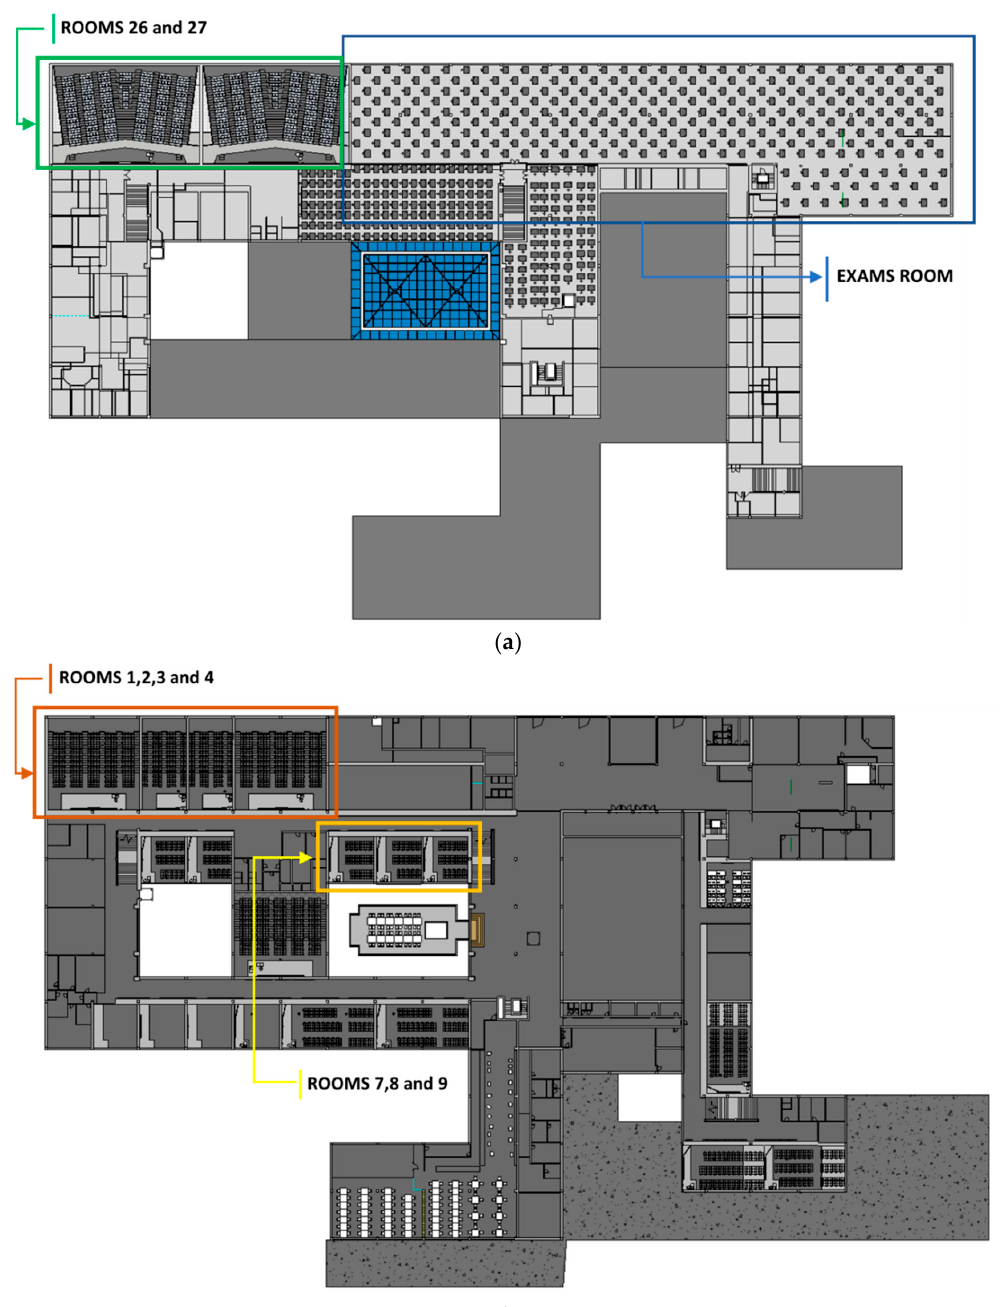
Figure 16. ( a ). Location of rooms 26, 27 and exams room. ( b ). Location of rooms 1 to 4 and 7 to 9. Occupation rates vary from 50% to even less than 10% in specific spaces. That hy- pothesis provides the maximum and minimum occupation rate and, therefore, economic and consumption savings. In terms of consumption, only the exam room could provide a maximum saving of 109,644.49 kWh each year. Turning it into economic parameters, it could provide a maximum saving of more than 5000 €. Other main spaces such as Room 26 and 27 could provide a total consumption saving of 56,172.12 kWh and a total economic saving of 2812.25 € for each one. Following this analysis, if this research were applied to the whole infrastructure, affecting all spaces, a total saving of 418,928.40 of kWh and 20,963.70 € (17.8% reduction) could be reached in one year period, as it is shown in Figure 17.